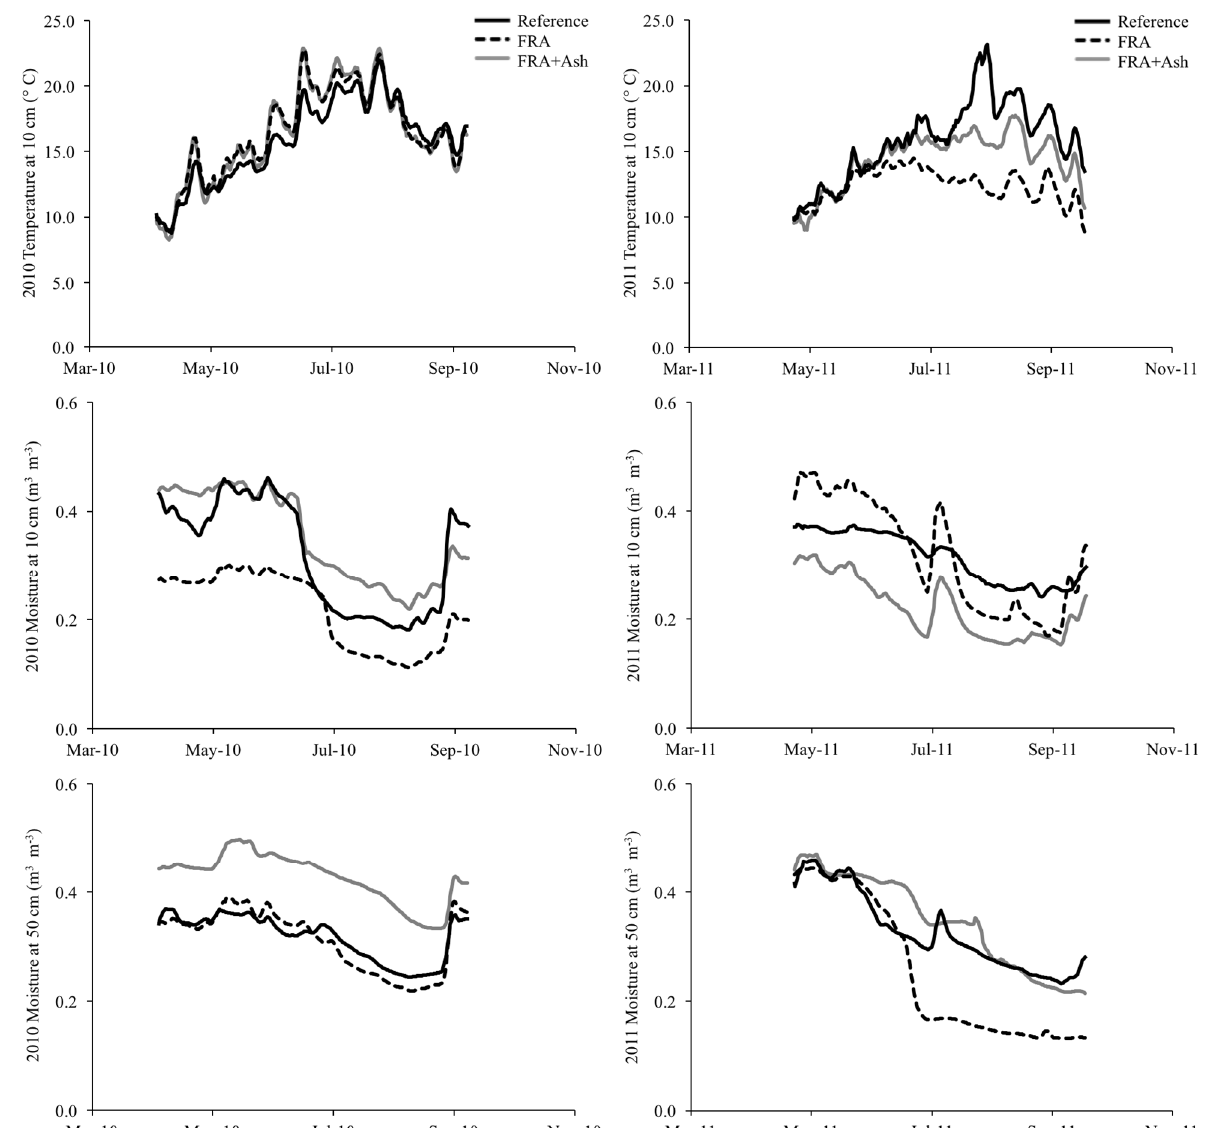
Figure 5. Soil temperature at 10 cm, and soil moisture at 10 cm and 50 cm for the first (2010) and second (2011) growing seasons. Reference (solid black line) is the standard mine reclamation technique, FRA (dashed black line) is the modified Forestry Reclamation Approach, and FRA + Ash (solid grey line) is the modified Forestry Reclamation Approach with an addition of bottom ash from the on-site coal burning power